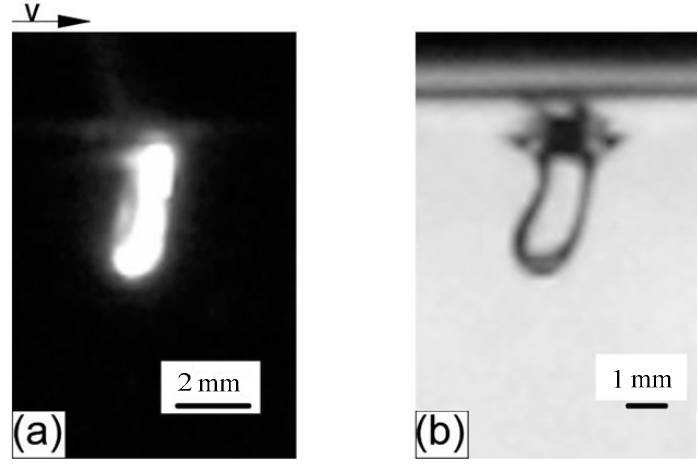
Figure 16. Obtained keyhole: ( a ) Keyhole in real deep penetration laser welding; ( b ) Keyhole in